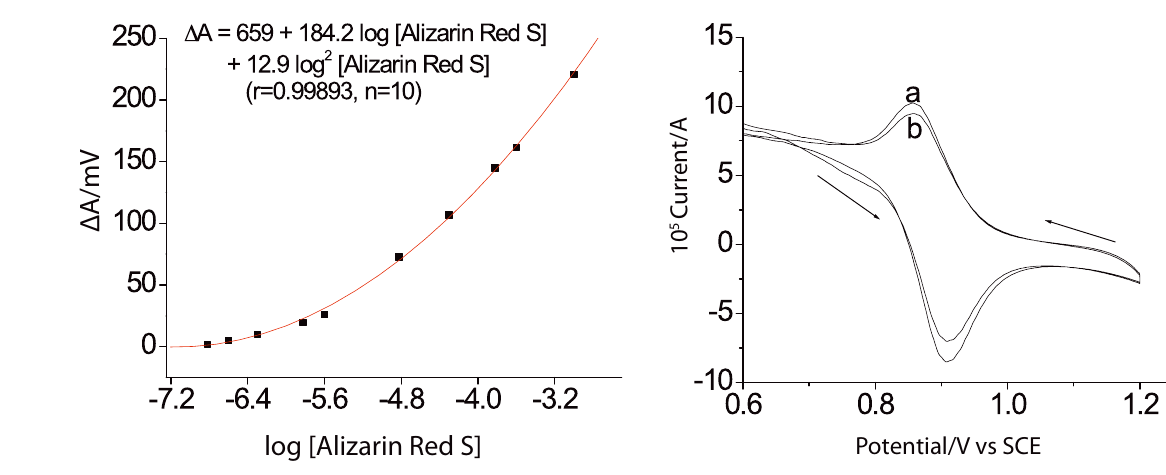
Figure 3. Calibration curve of the increase in amplitude versus Figure 4. Cyclic voltammograms of the reactions in (a) [Sodium the logarithm of [Alizarin Red S] in the range 1.5 × 10 -7 bromate] = 0.06 M, [Sulfuric acid] = 0.9 M, [Alizarin to 1 × 10 -3 M. (Common conditions: [NaBrO ] = 0.018 M; Red S] = 0; (b) [Sodium bromate] = 0.06 M, 3 [malic acid] = 0.195 M; [H [Sulfuric acid] = 0.9 M; [Alizarin Red S] = 1.5 × 10 -6 M; SO ] = 0.9 M; 2 4 ) = 3.08 × 10 -3 M) [CuL](ClO scan rate = 100 mV s -1 4 2